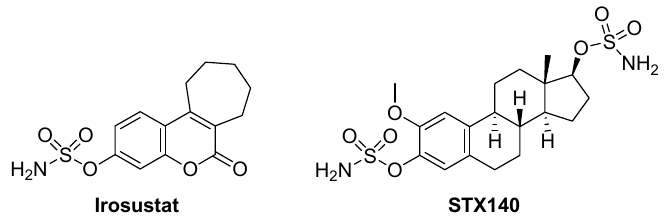
Figure 1. Structures of Irosustat and STX140.